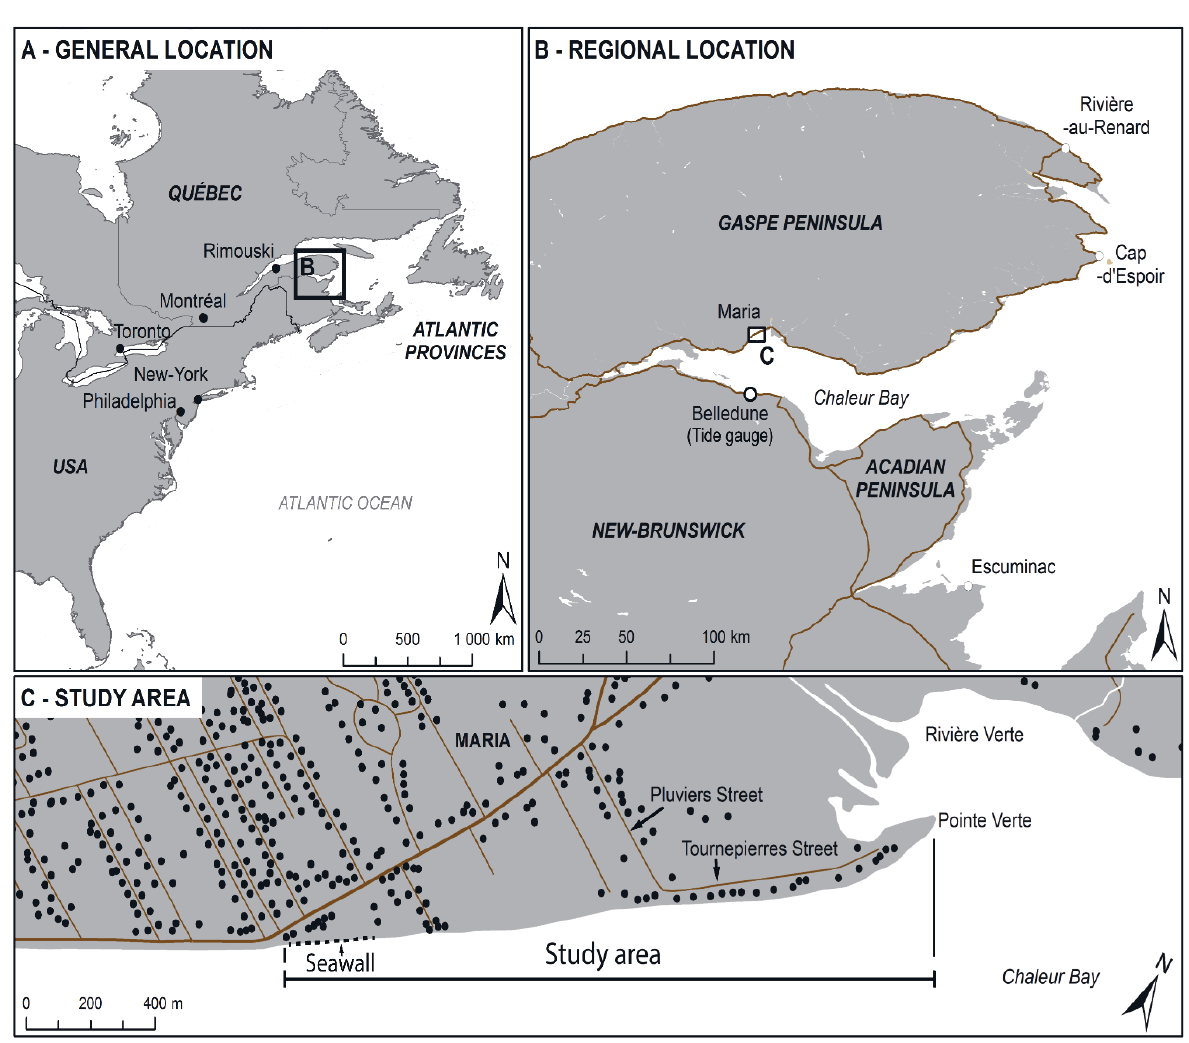
Figure 1. Location map of the study area in Maria (Quebec) on the north shore of the Chaleur Bay. At the western zone of the study site, almost the entire beach has been eroded as a result of wave reflection and scouring at the wall toe [51,52] (Figure 2b). Beach erosion has exposed a substrate of pebbles and gravel (Figure 2b). Backshore elevation in this area is higher than in the eastern part of the site. The region experiences a semi-diurnal and meso-tidal regime, with a mean sea level (MSL) of 1.33 m relative to Chart Datum [76] (Table 1). During highest astronomical tide (HAT) (1.66 m), the seawall toe is submerged and oscillating water levels occur on the seaward face of the wall. As observed during the 2005 flood event [52], continuous wave overtopping can occur during periods of high water levels and large